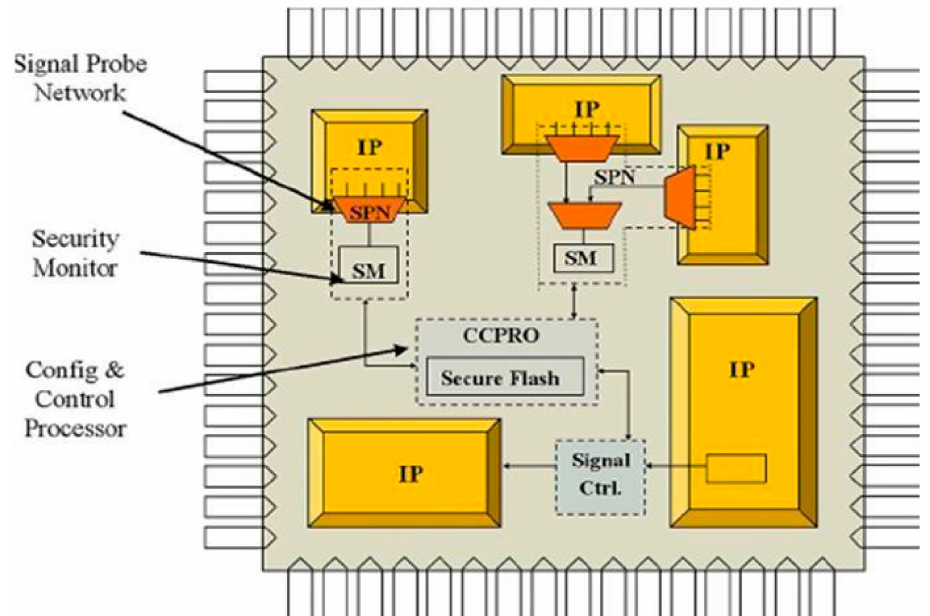
Figure 2. Insertion of a hardware